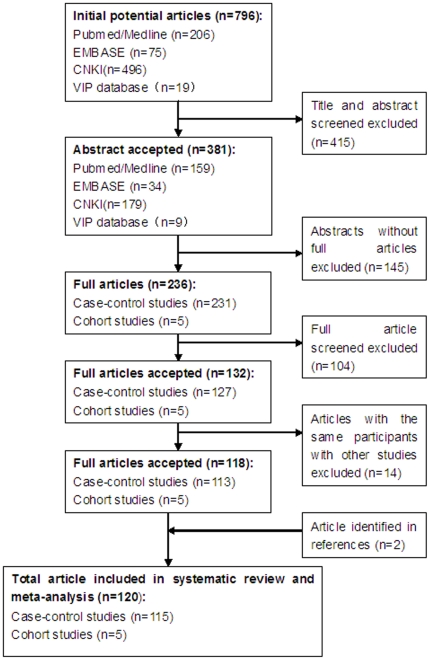
Results of literature search.This figure describes the whole process of searching for articles for inclusion in this systematic review and meta-analysis.